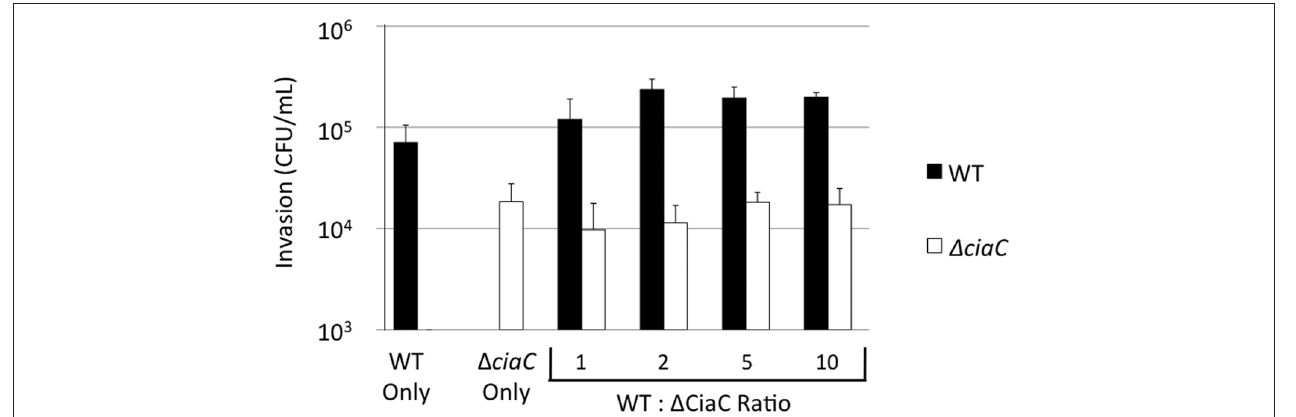
FIGURE 9 | Cia delivery by the C. jejuni F38011 wild-type strain cannot rescue the invasion of a ciaC mutant. A bacterial invasion assay was performed using the C. jejuni F38011 wild-type strain, the isogenic ciaC mutant, or a mixture of both strains. The numbers of internalized C. jejuni F38011 wild-type (black bars) and ciaC mutant (white bars) bacteria were determined at 3h post-infection using the gentamicin